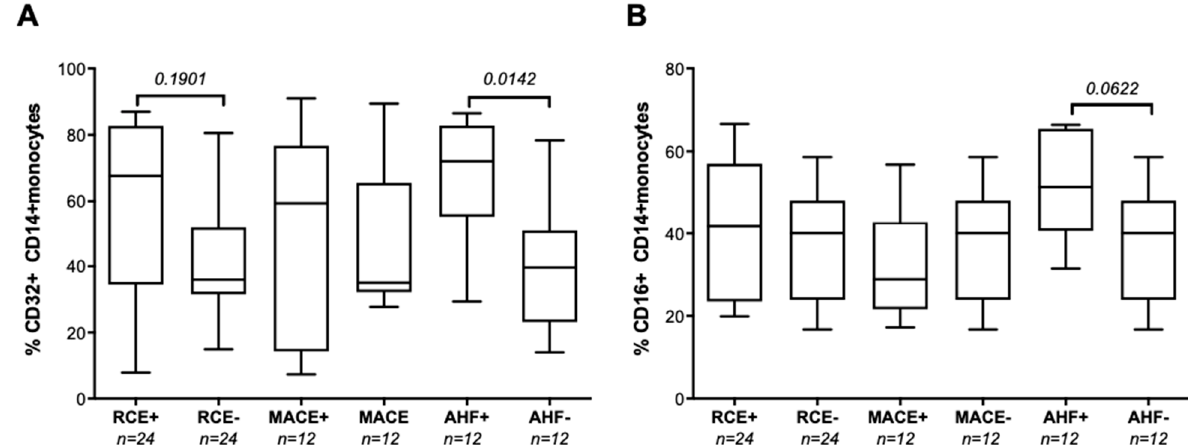
Figure 2. Flow cytometry analysis of circulating CD32+ and CD16+ monocyte. ( A ) Comparative analysis of circulating hsCRP levels was analyzed in RCE (RCE+, n = 27) and non-RCE patients (RCE-, n = 118). HsCRP levels were then analyzed in the subgroups of patients experiencing MACE (MACE+ group, n = 18, among which 14 patients were MACE+AHF- and 4 patients experienced both MACE and AHF episodes during the first year post PCI) or AHF (AHF+ group, n = 13, 9 AHF+MACE- and 4 AHF+MACE+ patients) analyzed in reference to patients without MACE (MACE-, n = 127) or free of AHF (AHF-, n = 132) at one year post ACS. hsCRP variables are described in box and whiskers plots as medians and (10–90 percentile) using GraphPad Prism. Comparison between groups were performed using Mann–Whitney non-parametric unpaired t tests. p values <0.05 were reported as significant. ( B ) Flow cytometry analysis of the percentage of CD14+ monocytes expressing the CD16 receptor. Peripheral blood monocytes expression of CD16 could be analyzed in 24 RCE patients analyzed in reference to a group of 24 RCE-free patients (RCE-) without a MACE or AHF event, matched for age, gender, and CKD status. Monocyte CD16 expression in RCE patients was further analyzed in a subgroup of 12 MACE+AHF- patients and 12 AHF+ patients (among which 3 were AHF+MACE+ and also experienced a MACE event, and 9 were AHF+MACE- and only experienced AHR during the first-year post ACS). Groups of RCE+, MACE+, and AHR+ patients were analyzed using Mann–Whitney non-parametric unpaired t tests and compared to proportion of CD16+ CD14+ monocytes observed in gender-, age-, and CKD status-matched groups of AHR-MACE- patients. p values <0.05 were reported as significant. p values ≥ 0.05 and < 0.2 were indicated as a trend for significance.